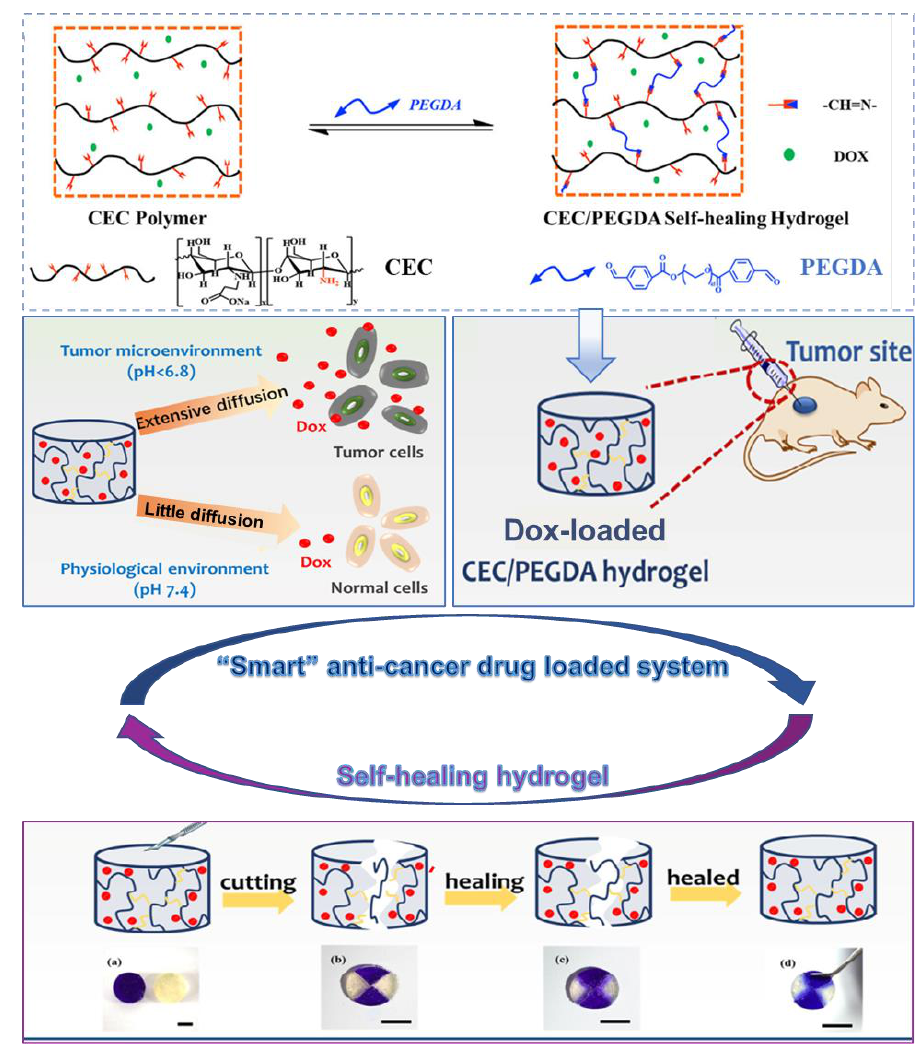
Figure 9. Self-healing hydrogels with pH-sensitivity as drug delivery vehicles for hepatocellular carcinoma therapy and photographs of self-healing performance of CEC/PEGDA hydrogels. ( a ) Two disk-shaped hydrogels (one stained with crystal violet and the other stained with FITC); ( b ) Hydrogels were cut into four equal pieces and put together; ( c , d ) The hydrogels healed completely into one block after 3 h at 25 °C. Reprinted with permission from Ref. [113]. Copyright 2017, copyright with permission from Qu and Zhao.